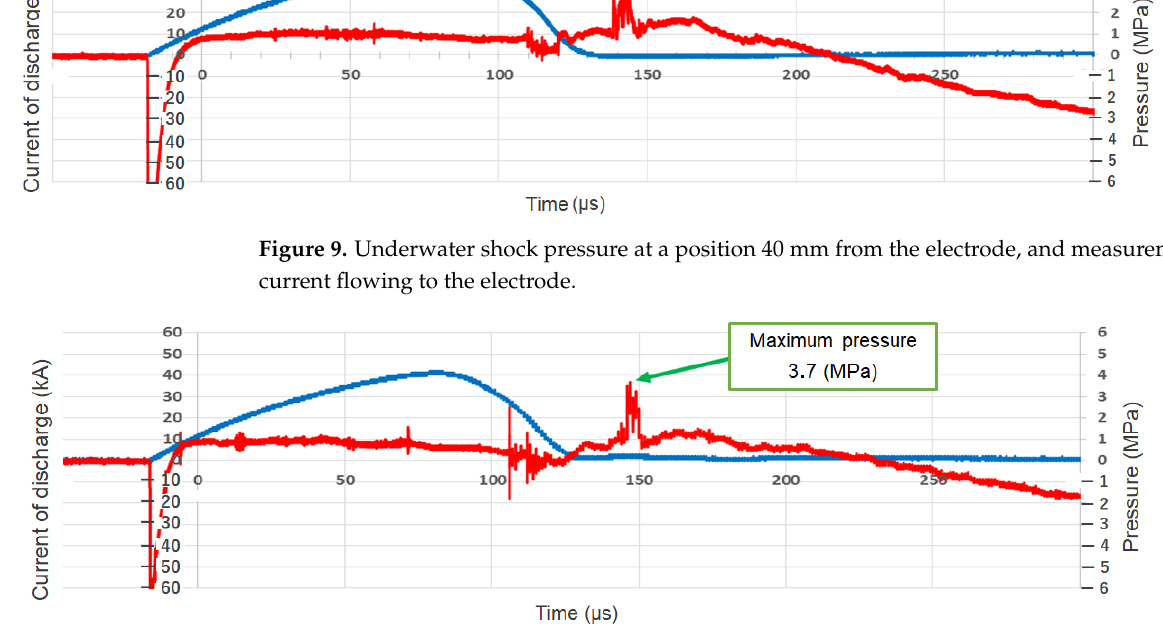
Figure 10. Underwater shock pressure at a position 50 mm from the electrode, and measurements of current flowing to the electrode.